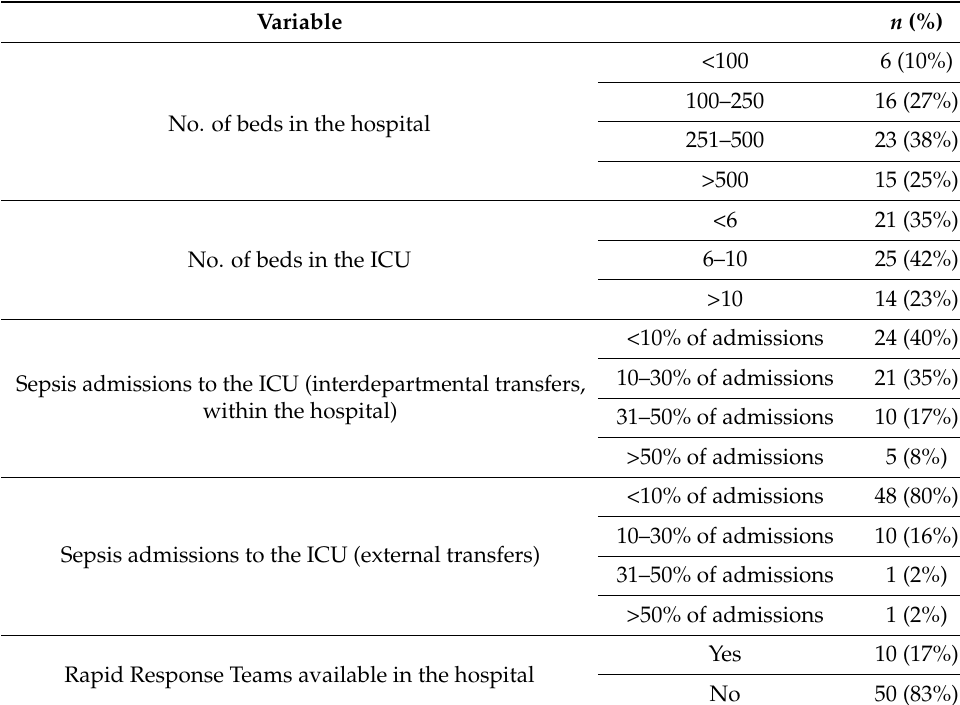
Figure 2. Methods of sepsis screening used in the ICU and outside the ICU. The Quick Sequential Organ Failure Assessment Score (qSOFA) includes one point for each of the following: respiratory rate ≥ 22, SBP ≤ 100 mm Hg, and altered mental status. For screening purposes, a cut-off of two points is used [14]. National Early Warning Score 2 (NEWS2) assigns points to measurements of respiratory rate, SpO2, air or oxygen ventilation, systolic blood pressure, pulse, state of conscious- ness, and body temperature, with increasing severity the higher the calculated sum [14]. Inflam- matory parameters include any of the following: C-reactive protein (CRP), procalcitonin (PCT),